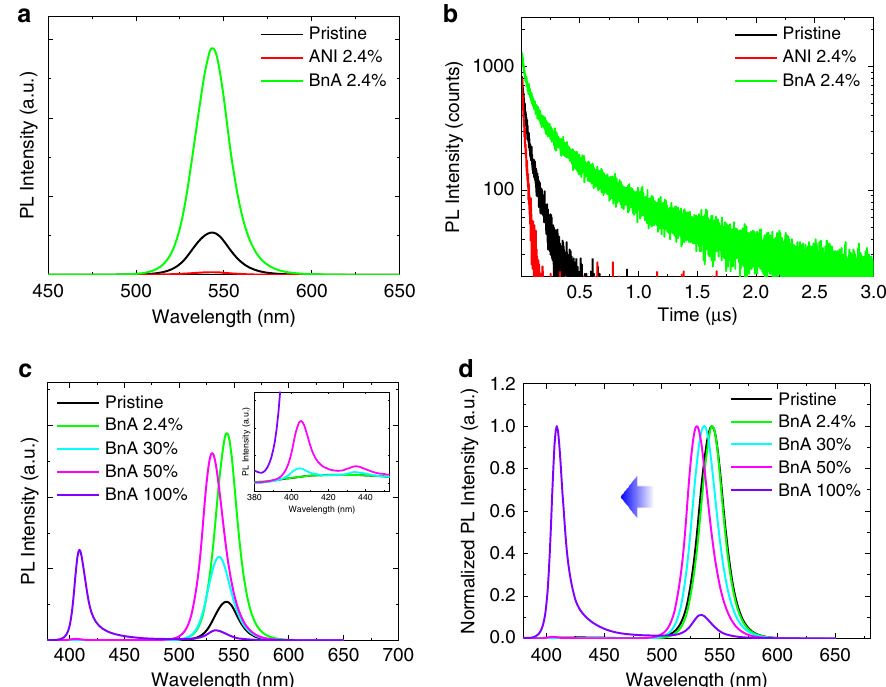
Fig. 4 PL characteristics of perovskites and the trap passivation. a PL spectrum of pristine MAPbBr 3 fi lm (black), fi lm with 2.4 mol% of ANI (red), and 2.4 mol% of BnA (green). b PL lifetime curves of pristine MAPbBr 3 fi lm (black), fi lm with 2.4 mol% of ANI (red), and 2.4 mol% of BnA (green). c PL spectra of MAPbBr 3 fi lm with different amount of BnA and magni fi ed PL spectra at low wavelength region (inset). d Normalized PL spectra of MAPbBr 3 fi lm with different amount of